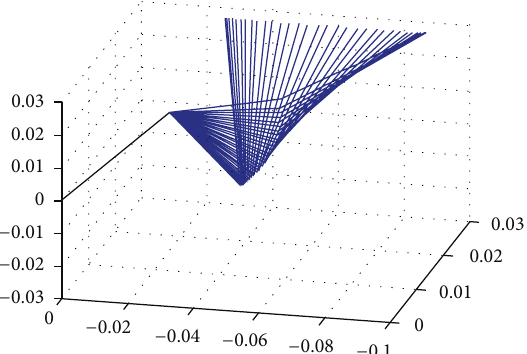
Figure 29: Motion due to shoulder griddle, glenohumerals, and elbow joint movement.